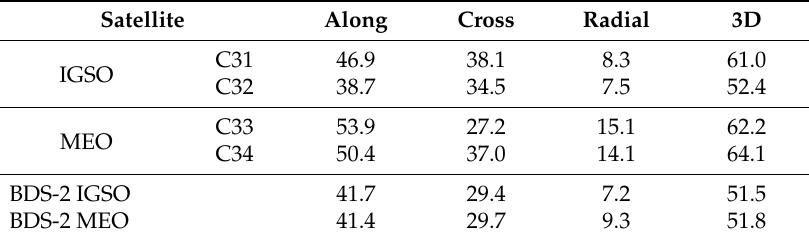
Table 5. Averaged RMS values of 48-h orbit overlap errors for BDS-2 satellites using only the reference stations with BDS-3 and BDS-2 simultaneous tracking capability (unit: cm). Satellite Along Cross Radial IGSO